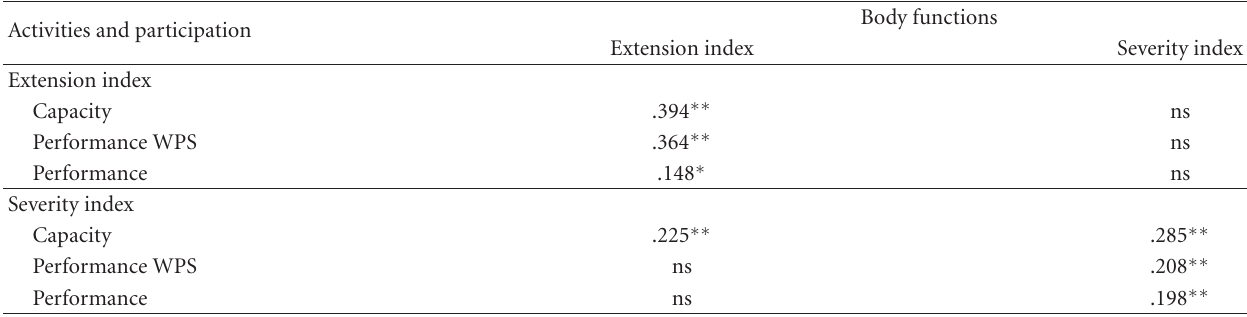
Table 1: Spearman’s RHO correlation between BF and A&P indexes ( N =